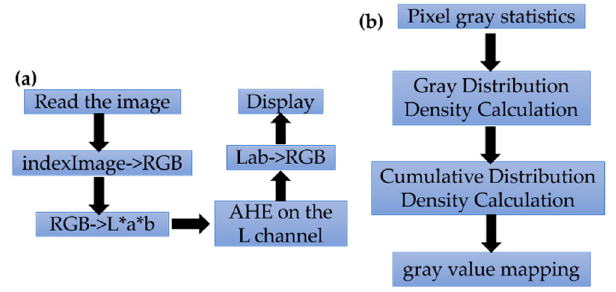
Figure 5. The overall optimization procedure: ( a ) the overall AHE optimization; ( b ) the detail of the Figure 5 . The overall optimization procedure: (a) the overall AHE optimization; (b) the detail of the AHE AHE process.